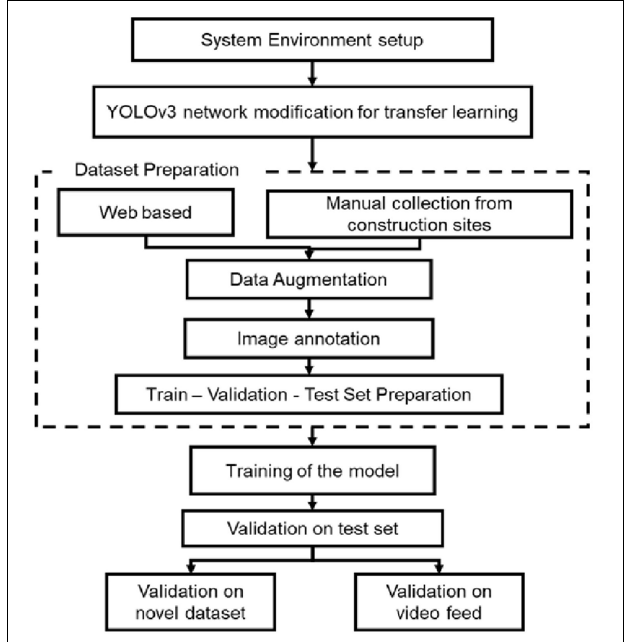
FIGURE 1 | Research methods used for the